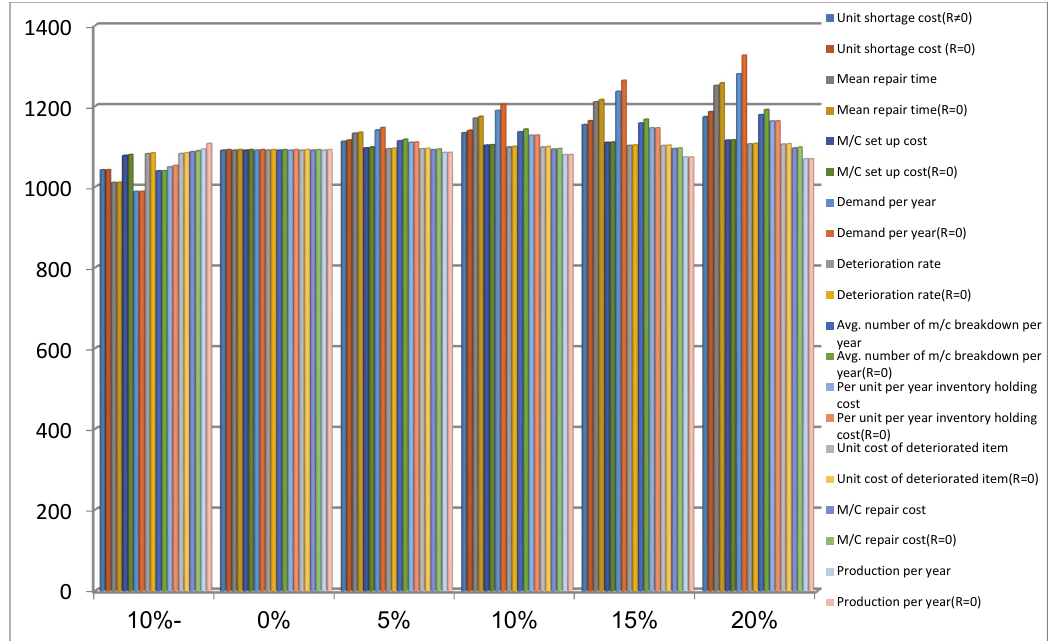
Fig. 18. Comparison of expected total cost per year for percentage change of input